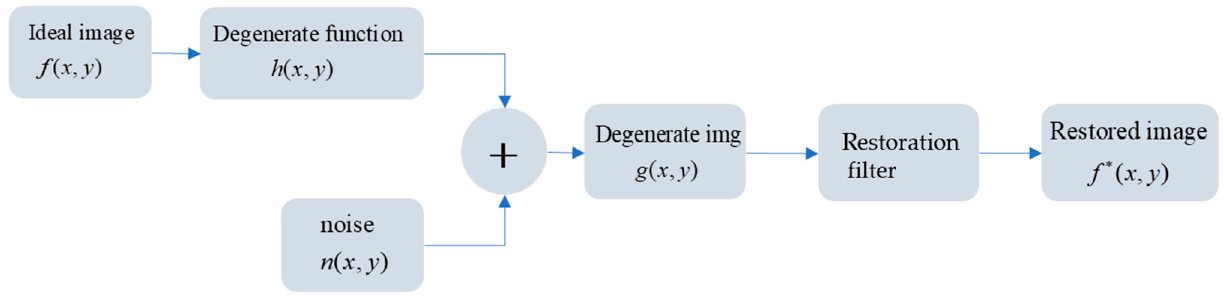
Figure 4. Process of image degradation and restoration.